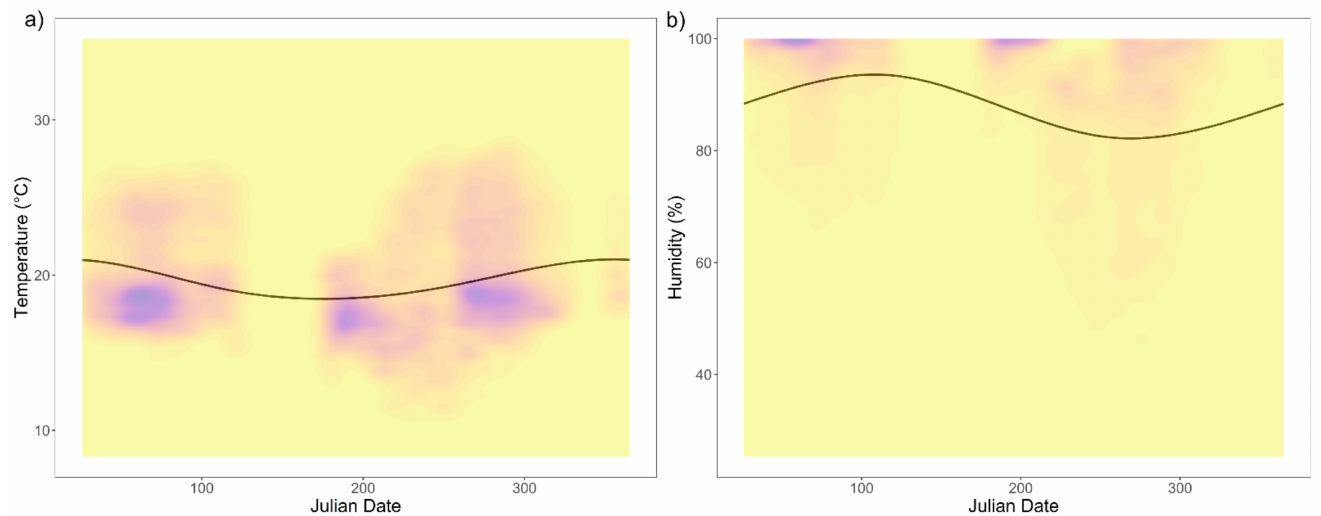
Figure 1. Heatmap showing the weather conditions, ( a ) temperature and ( b ) humidity, in relation to seasonality (Julian date) during the automatic data collection via accelerometers deployed on 12 Javan slow lorises (six females and six males) between June 2014 and October 2019. The black line indicates the mean